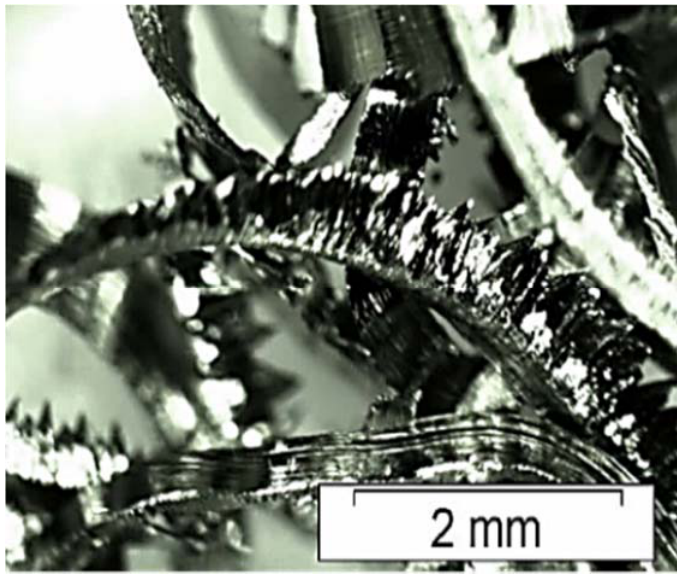
Figure 1. Stainless–steel duplex UNS S31803 in the form of machining chips.